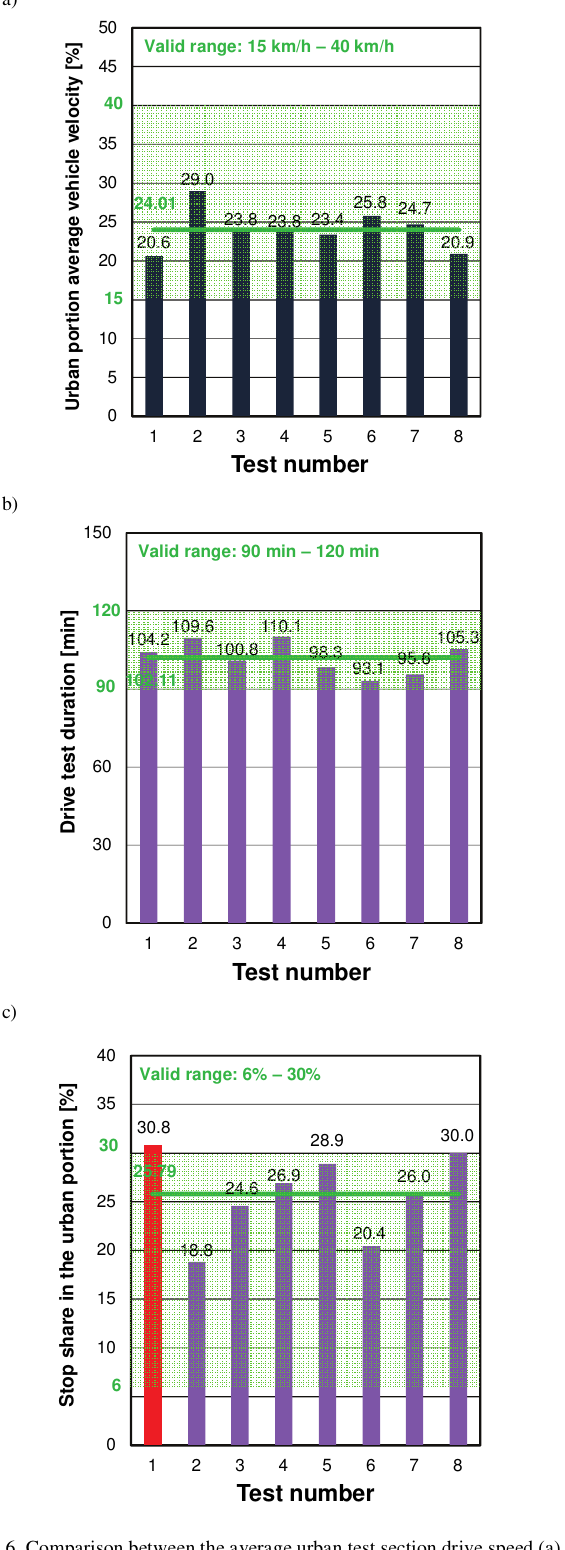
Fig. 7. Vehicle's operating time density in individual speed and accelera- tion ranges: a) for drive No. 5, b) for drive No. 6, c) for drive No. 7, d) for drive No.